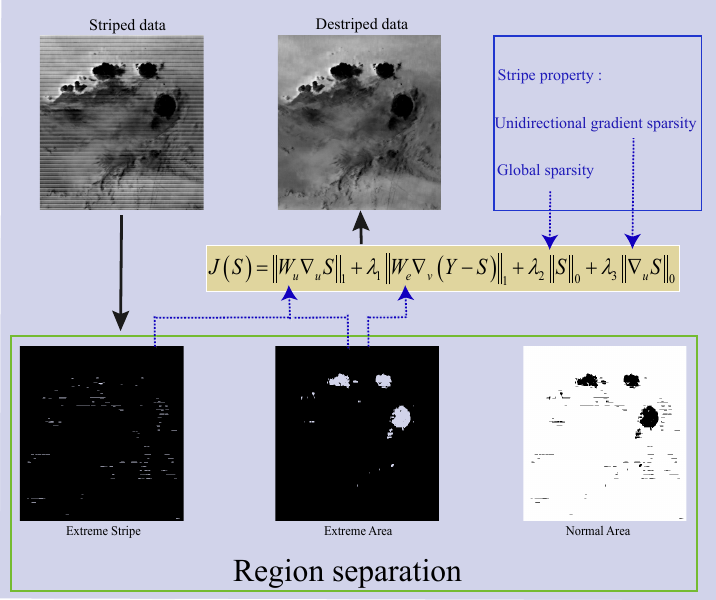
Figure 5. Flow chart of the proposed